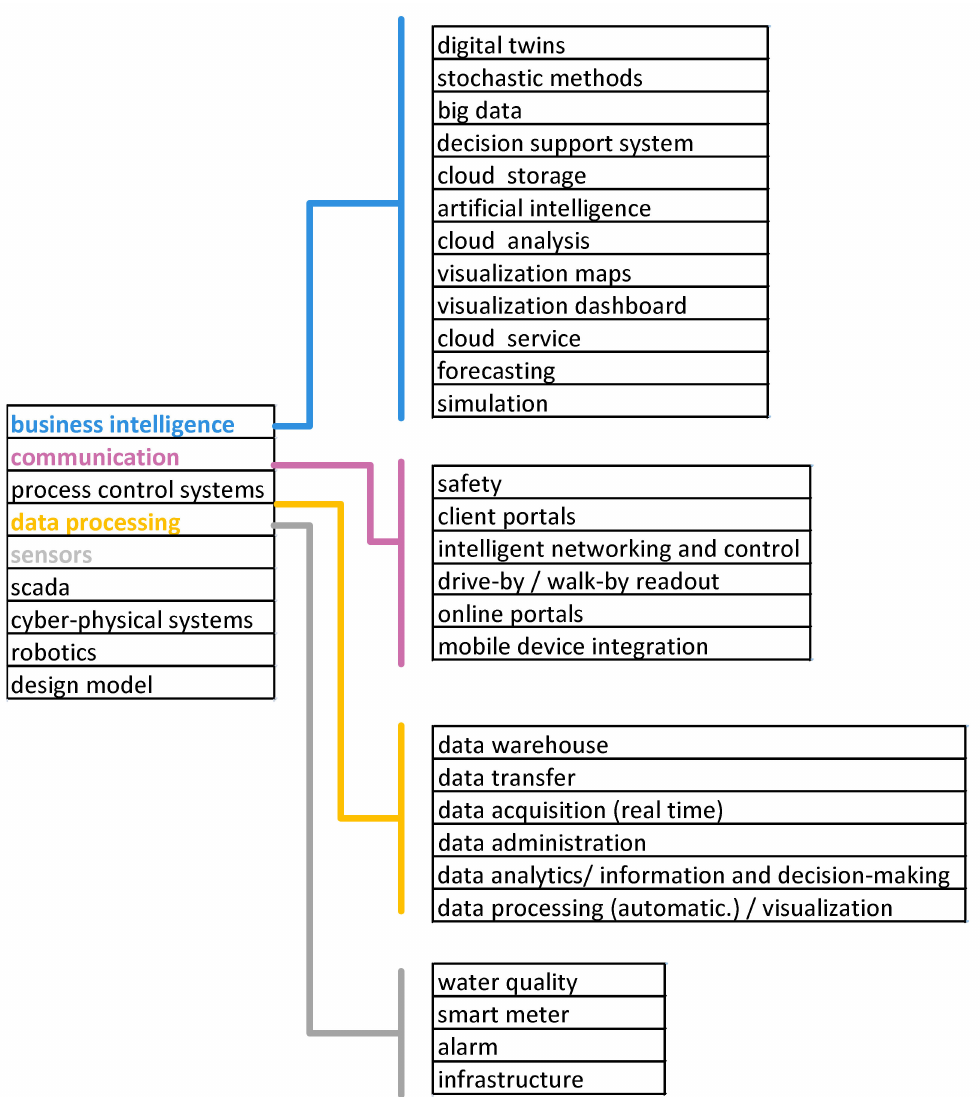
Figure 1. Structure of the category